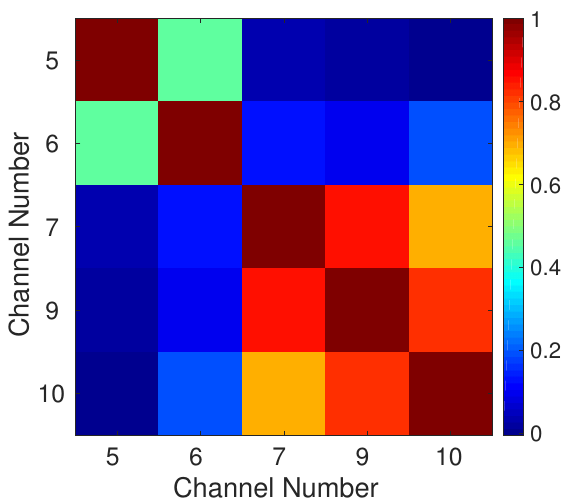
Figure 1. Estimated observation error correlation matrix for assimilated SEVIRI channels. We remark that more than 150,000 samples were used to calculate each entry of the inter-channel covariance matrix.